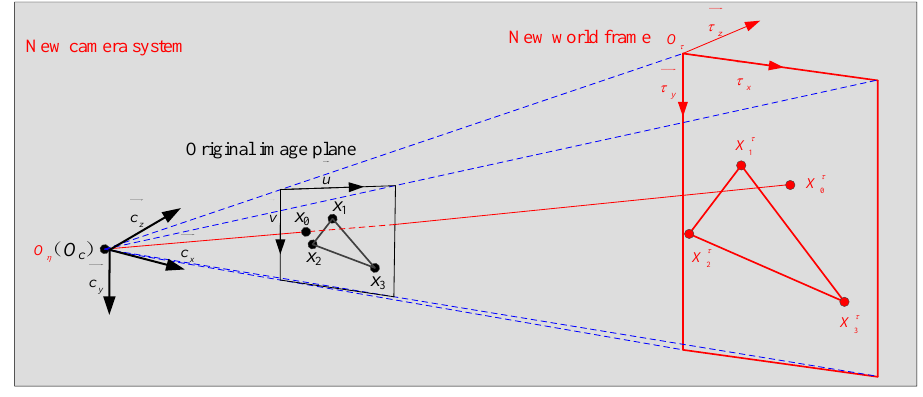
Figure 4. New camera system.